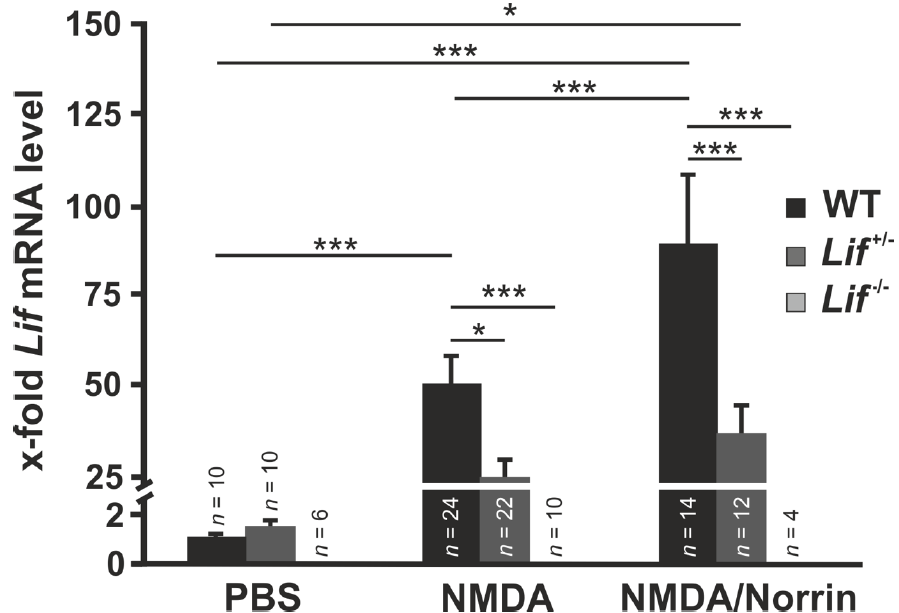
Figure 2. Norrin enhances N-methyl-D-aspartate (NMDA) induced Lif expression in mice retinae. Real-time RT-PCR on retinal total RNA for Lif from heterozygous ( Lif +/ − ) and homozygous, Lif-deficient mice ( Lif − / − ), as well as wild-type (WT) littermates 7 h after intravitreal injection of 3 µl PBS, 3 µL NMDA [10 mM] or 3 µL NMDA [10 mM] with Norrin [5 ng/µL]. * p < 0.05; *** p < 0.001.